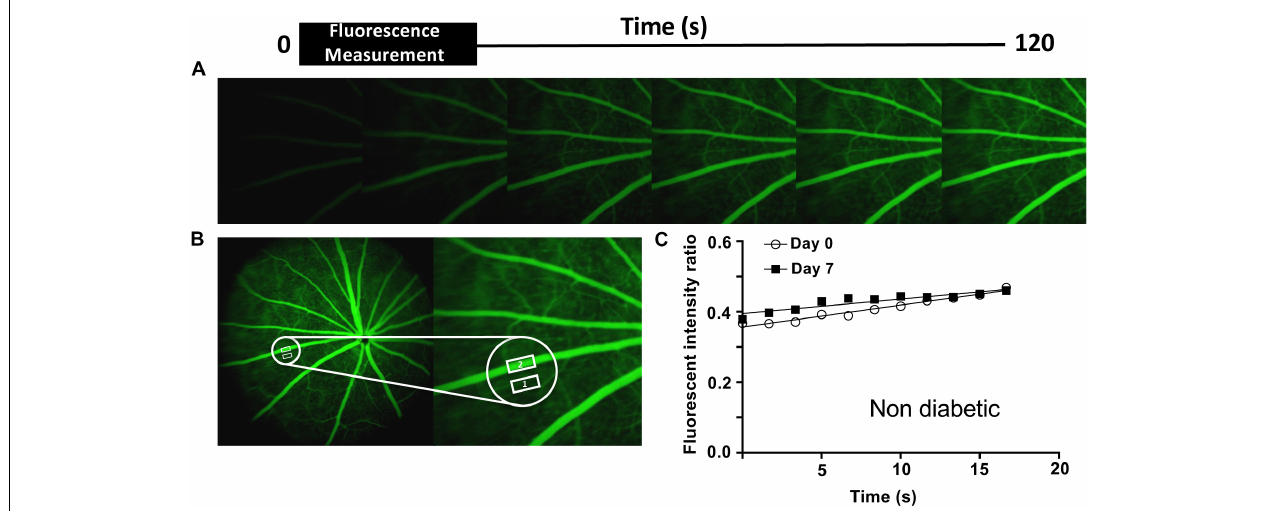
FIGURE 1 | Retinal permeability analysis model. (A) Fundus fluorescein angiography was performed in non- and diabetic Norway Brown rats treated ± H 2 S donors, on days 0 and 7. The angiograms shown are representative of a non-diabetic animal. (B) The mean intensity of NaF in the retinal tissue (Adamis and Berman, 2008) and a main retinal vessel (Ahmad et al., 2016) were measured every 200 frames for 3 min. (C) Apparent permeability (Permeability.Surface Area product, PA) was calculated from the rate of change of extravascular fluorescence (= (cid:49) I f / (cid:49) t) per unit concentration difference ( (cid:49) C) between blood and tissue. P = (cid:49) I f / (cid:49) t/( (cid:49) C x A). (cid:49) I f / (cid:49) t ∼ slope. (cid:49) C = difference between intra- and extravascular intensity.